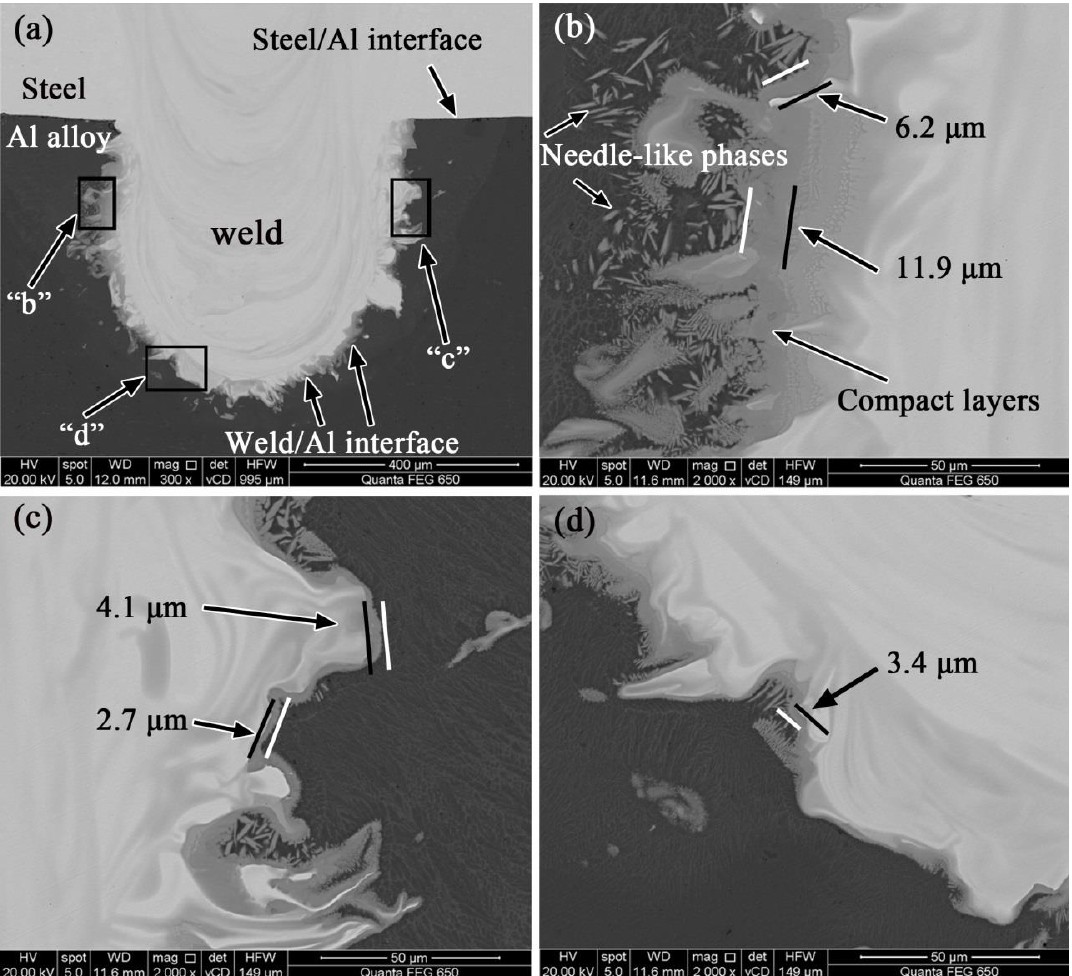
Figure 7. BSE images of the Al/weld interface microstructures of the steel/Al joint having a P2 of 477 µ m produced by dual-beam laser welding with side-by-side configuration: ( a ) Cross section of the steel/Al joint and the location of Zones “b”–“d”; ( b ) Enlarged view of Zone “b”; ( c ) Enlarged view of Zone “c”; ( d ) Enlarged view of Zone “d”.